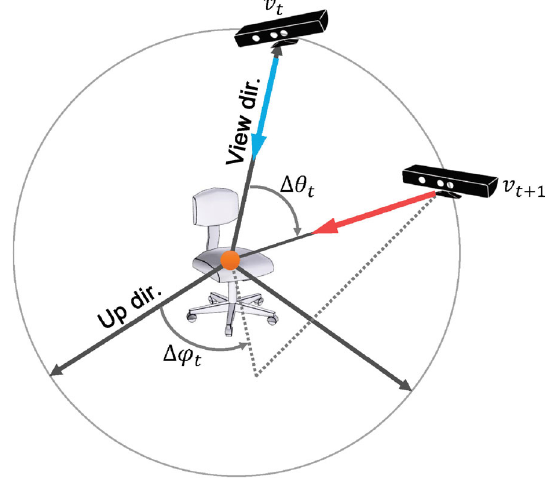
Fig. 2 The viewing sphere around the object being recognized. The view at the next time step, v t +1 , is parameterized in the local spherical coordinate system based on the current view v t